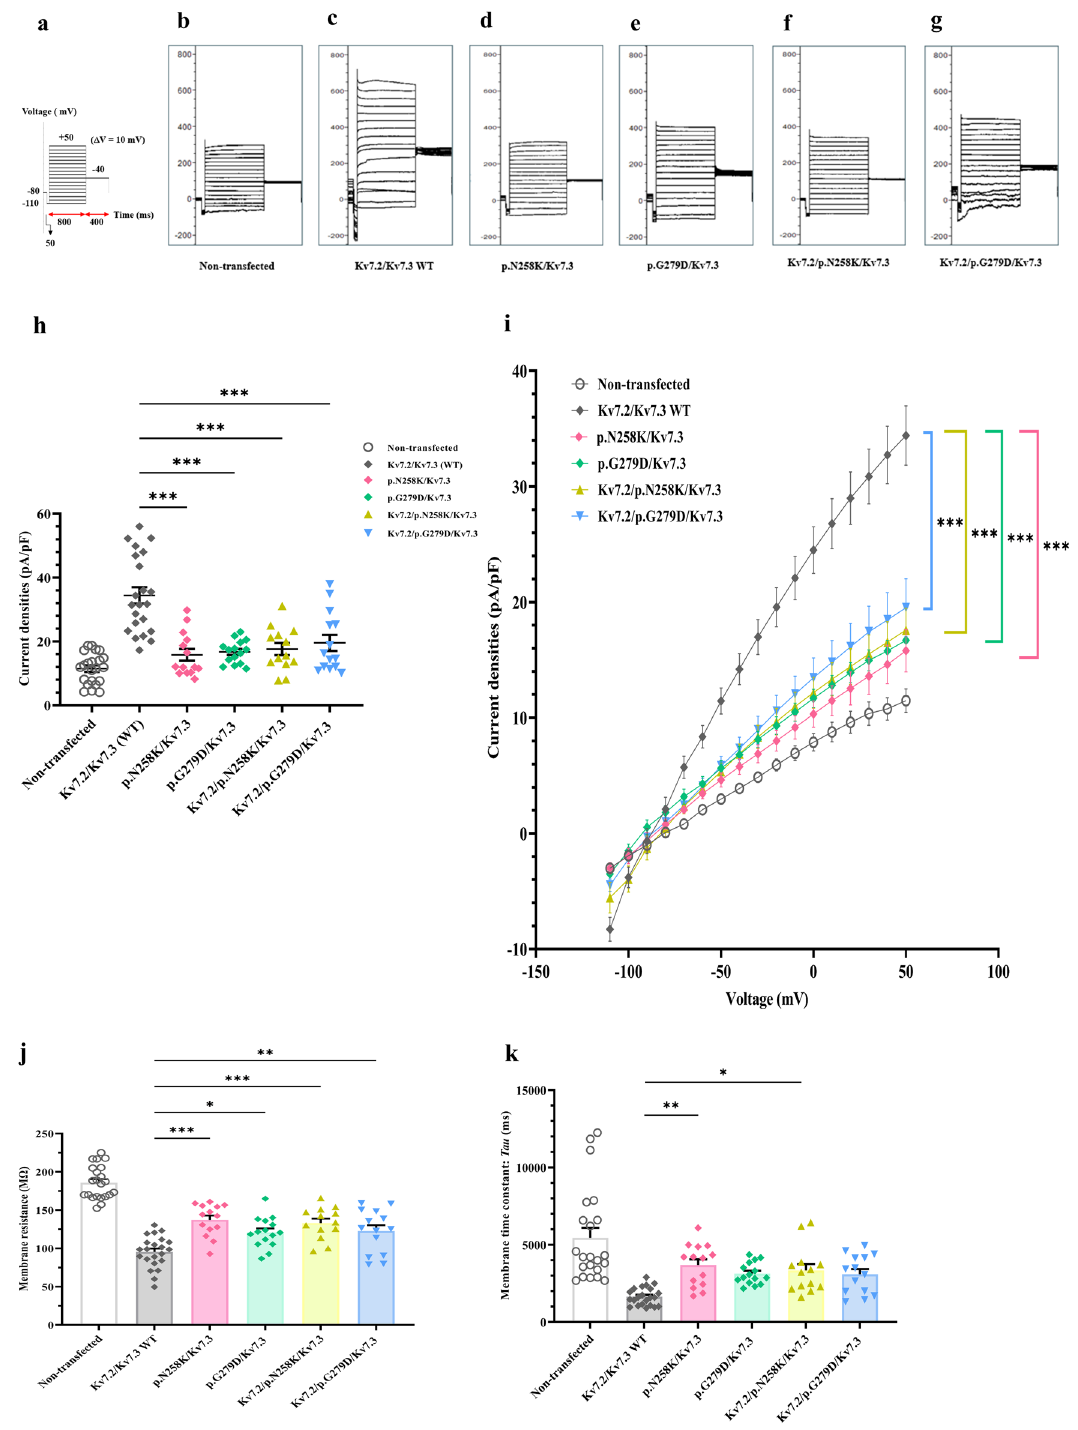
Figure 4. Whole cell patch clamp recordings of K + currents in of heterotetrameric Kv7.2/Kv7.3 channels. K + currents recorded in non-transfected cells or cells expressing Kv7.2/7.3 WT, p.(N258K) or p.(G279D) co-expressed with WT Kv 7.3 or WT Kv 7.2/7.3 ( a ) Voltage protocol with voltage-clamp steps as Fig. 3a. ( b – g ) Representative raw current traces for non-transfected cells (n = 22) (b) , Kv7.2/Kv7.3WT (n = 22) ( c ), p.(N258K)/Kv7.3 (n = 14) ( d ), p.(G279D)/Kv7.3(n = 15) (e), Kv7.2/p.(N258K) /Kv7.3 (n = 13) (f), Kv7.2/G279D/ Kv7.3(n = 14) (g). ( h ) average peak M-current densities (pA/pF) at + 50 mV. (i) Conductance–voltage (I–V) curves, significant differences from − 50 to + 50 mV. ( j ) membrane resistance (Rm). ( k ) membrane time constant (Tau). One-way ANOVA followed by Tukey post-hoc test, * p < 0.05, ** p < 0.01, *** p < 0.001 based on one-way ANOVA Tukey